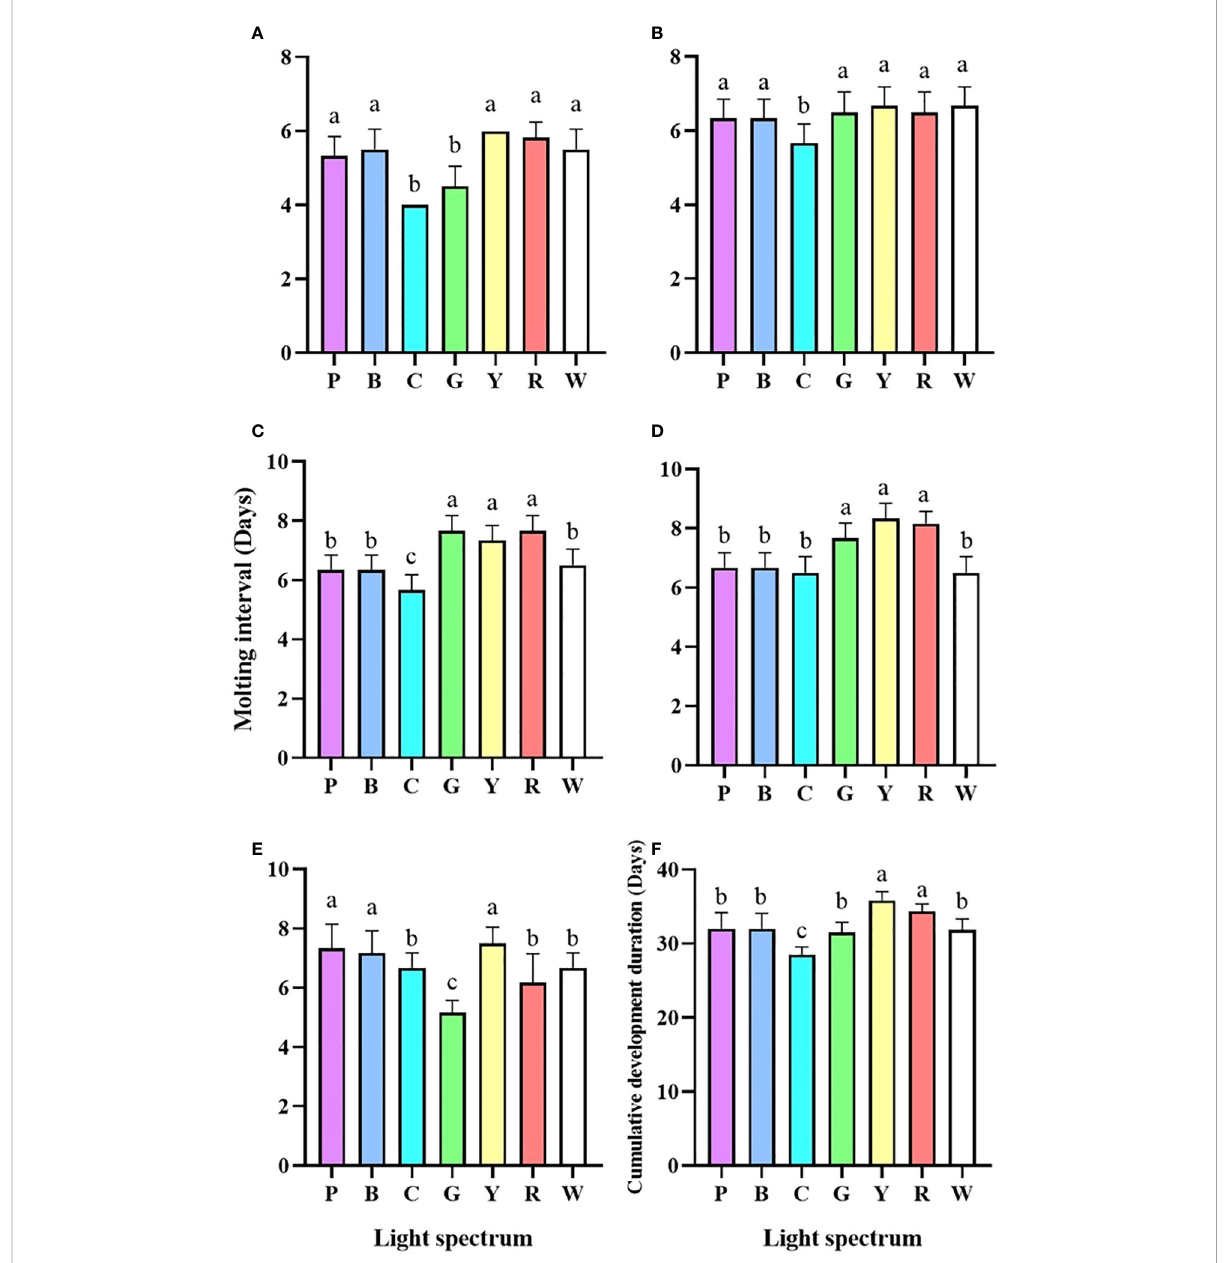
FIGURE 2 Molting interval (Zoea I - Zoea II) (A) , Molting interval (Zoea II - Zoea III) (B) , Molting interval (Zoea III - Zoea IV) (C) , Molting interval (Zoea IV - Megalopa) (D) , Molting interval (Megalopa - C1) (E) and Cumulative development duration (F) of P. trituberculatus larvae under different light spectrum (mean ± SD) (n=6). P, Purple; B, Blue; C, Cyan; G, Green; Y, Yellow; R, Red; W, White. Different letters indicate signi fi cant differences between treatment groups ( P